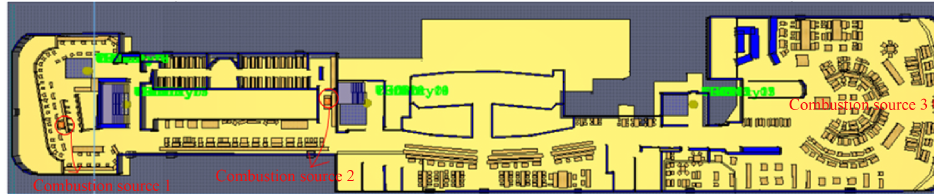
Figure 6. Model of the fire on the second floor of the cruise ship.